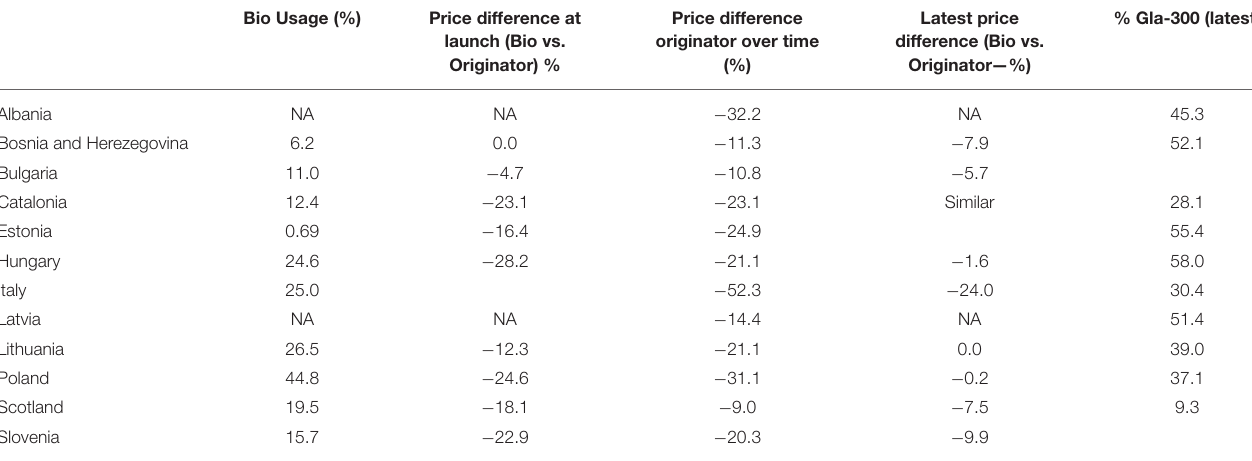
TABLE 7 | Key characteristics of the insulin glargine market (100 IU/ml) among European countries.